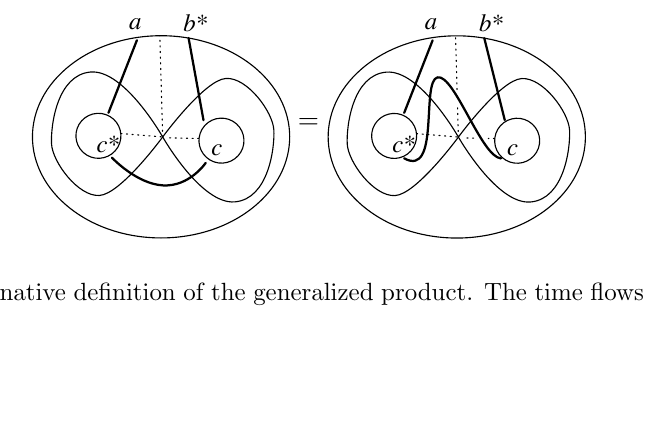
Figure 47 . A slightly generalized version of the product operation. In the (cid:12)gure on the right, the time (cid:13)ows from inside to the outside.